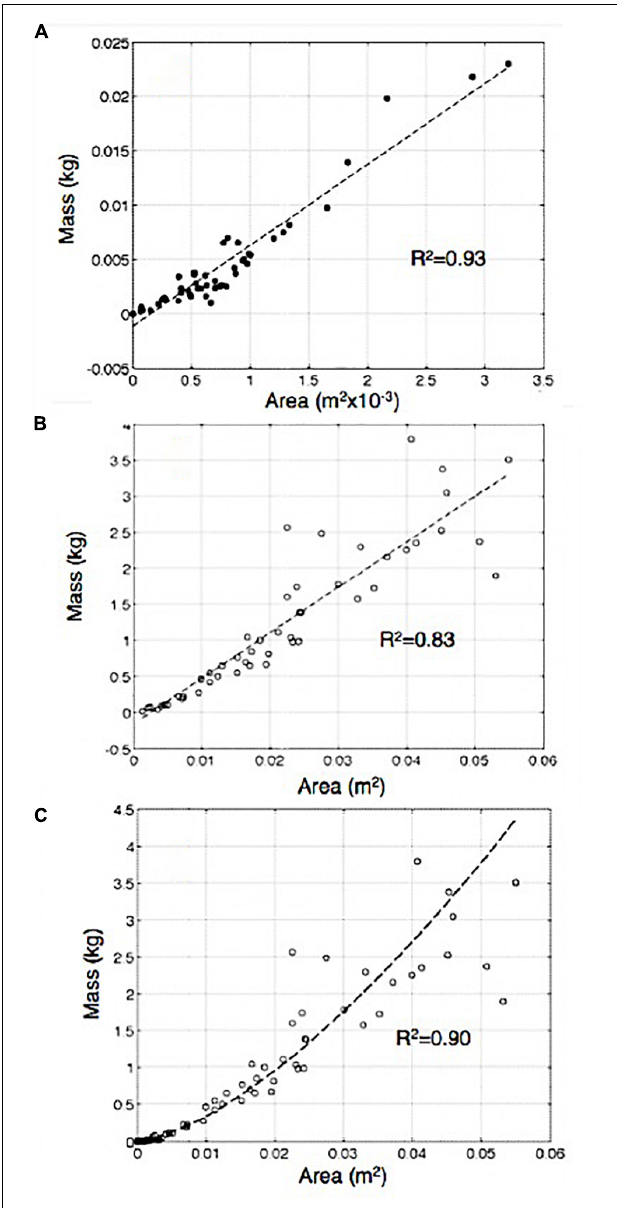
FIGURE 5 | (A) Area of the fragments as function of mass measured for clasts remaining stuck to the tarps. (B) Area and mass relation for bombs sampled and measured after a major explosion at Stromboli. (C) Mass vs. area for both data sets.